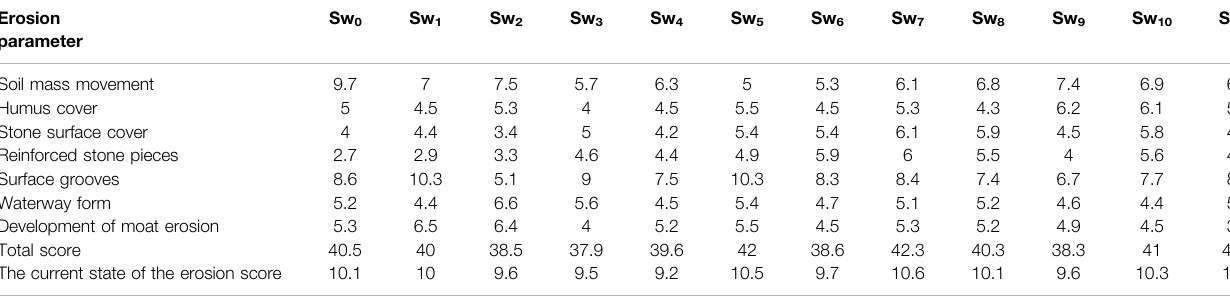
TABLE 7 | The score of nine parameters and amount of sediments in each sub-watersheds. Sub-watershed Geology